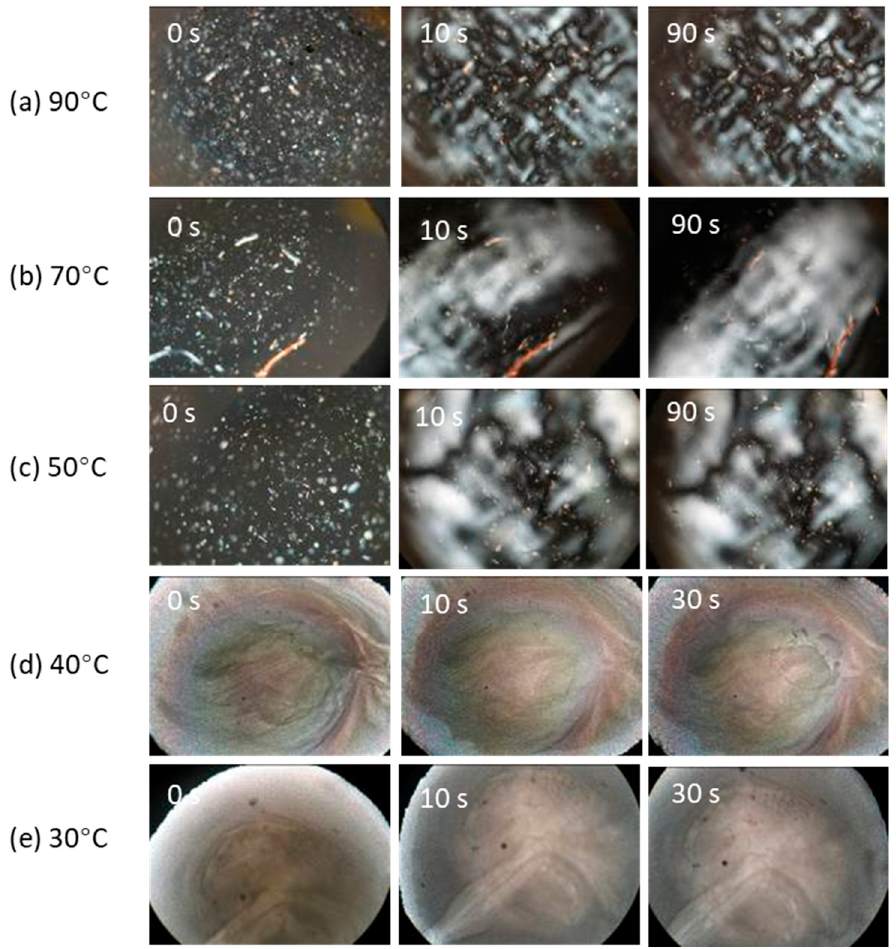
Figure 2. Polymerization-induced phase change/separation at temperatures from the nematic to the isotropic range. ( a – c ) polymerization started from the isotropic state, and ( d , e ) polymerization started from the nematic state. Magnification 100×.